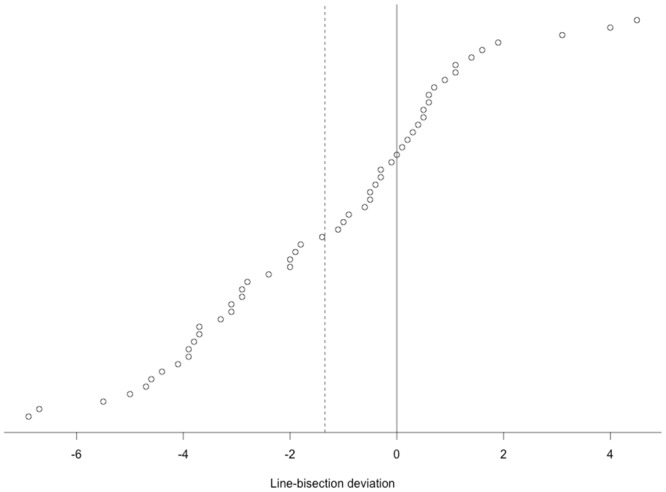
Distribution plot of the line-bisection results, i.e. the deviation for each subject in mm.Subjects are ordered by their linc-bisection performance value. The dashed line marks the average deviation.